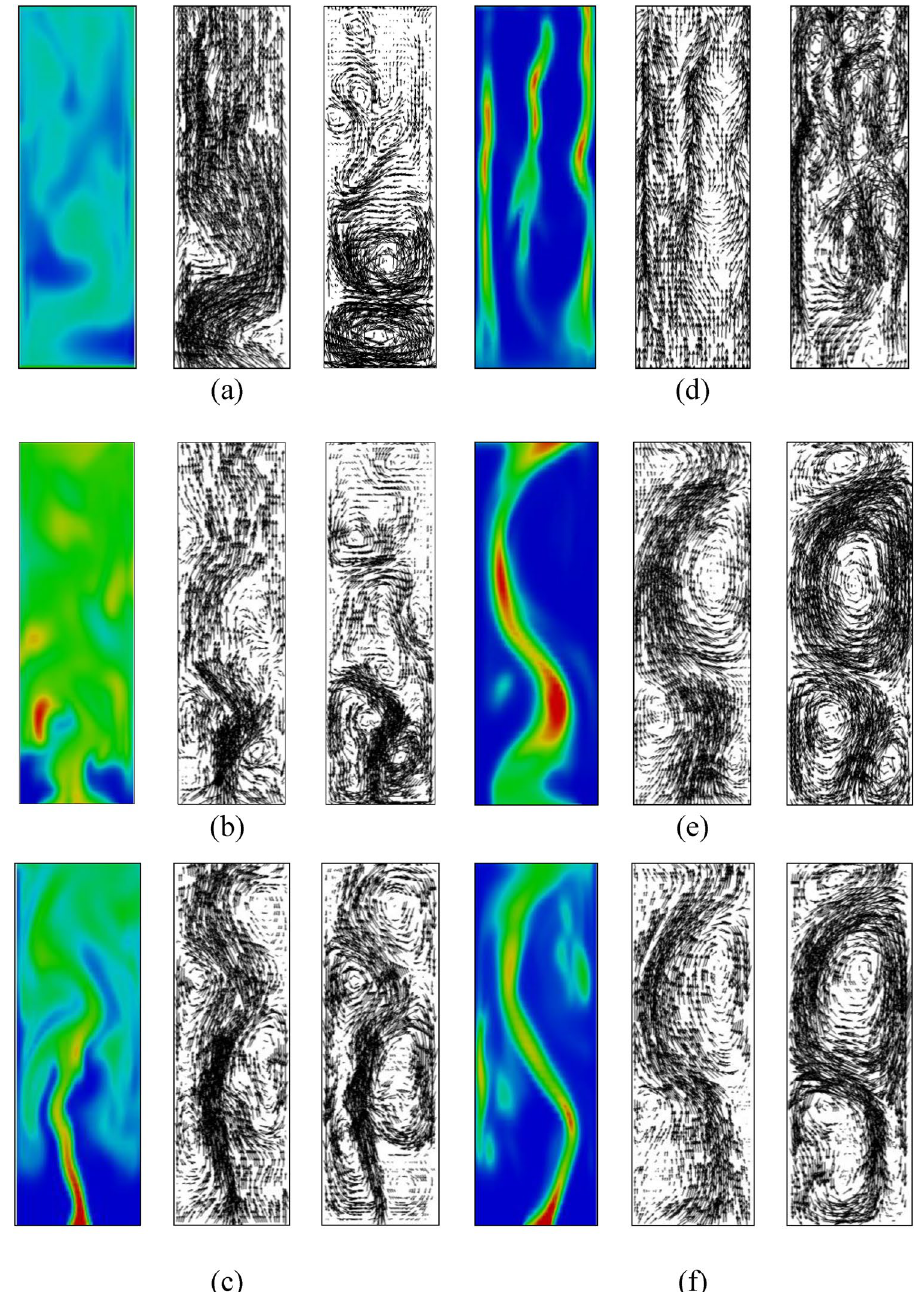
Fig. 13 Computational snap- shots of gas volume fraction distribution and correspond- ing liquid and gas velocity flow field for different bubble size at different sparger type a A1 (100%), 2 mm bubble; b A4 (69%), 2 mm